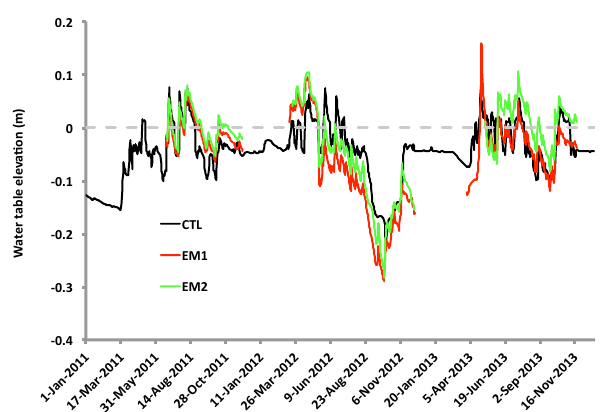
Figure 4. The comparison of CLM_SPRUCE simulated (CTL) and observed water table levels (EM1 and EM2) for hummocks for the years 2011 to 2013. Zero line indicates the surface of the hollow. For clarity, model results are shown only for the simulated hummock: simulated water table heights are nearly identical for hummock and hollow (Data are missing from EM1 and EM2 during winter when the bog surface is frozen and the water table sensors are not collect- ing